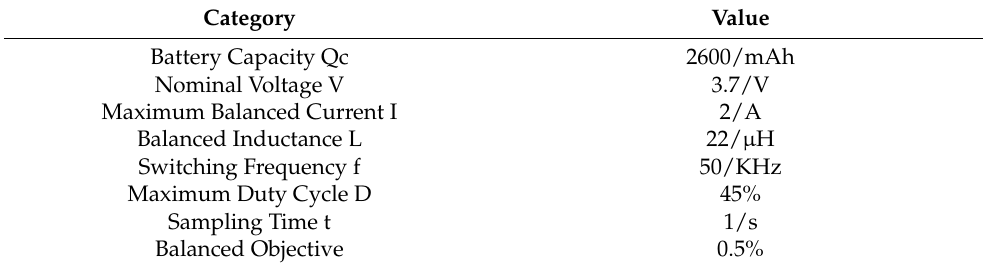
Table 2. Relevant parameters in the balance control design.